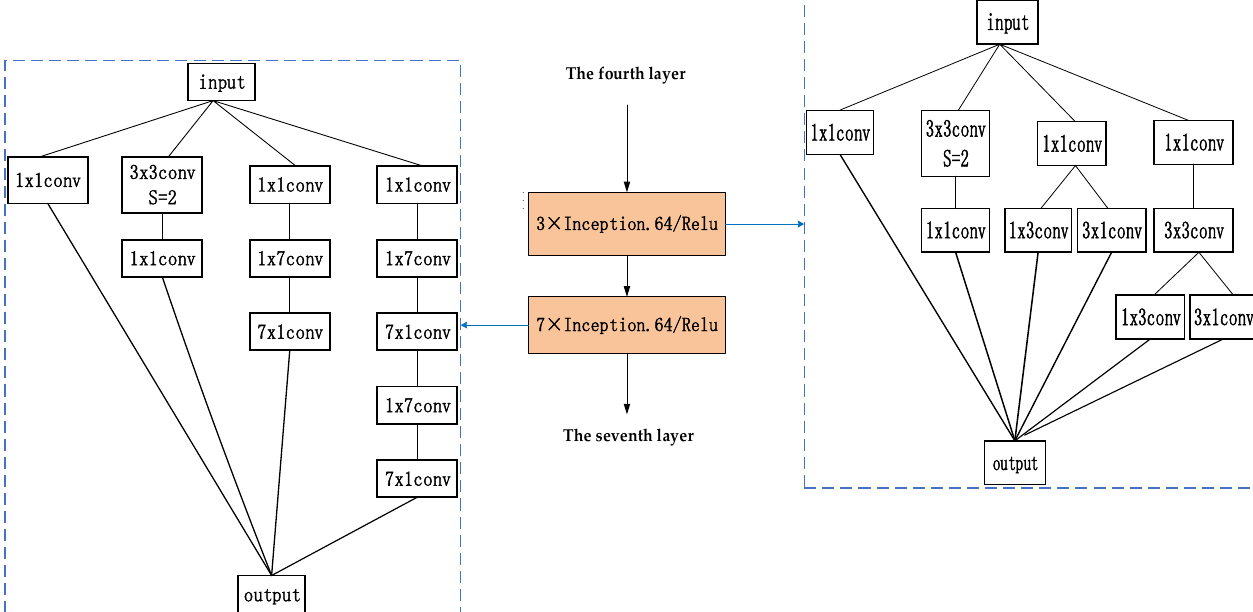
Figure 7. The fifth and sixth layers of network feature extraction.